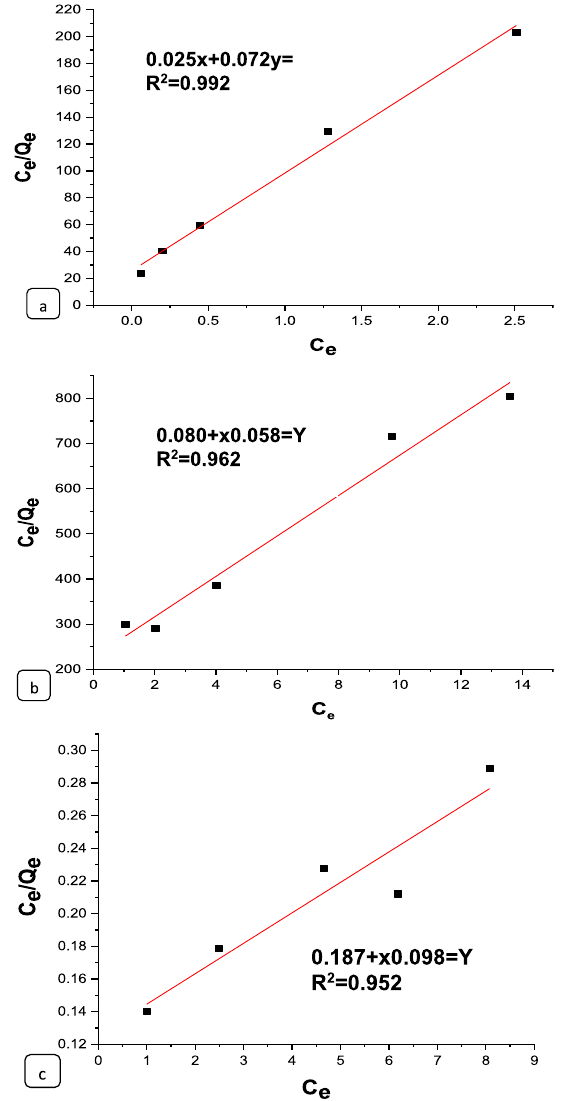
Fig. 17 Langmuir a nano-bentonite, b MgO impregnated clay and c raw bentonite plots for adsorption of MG